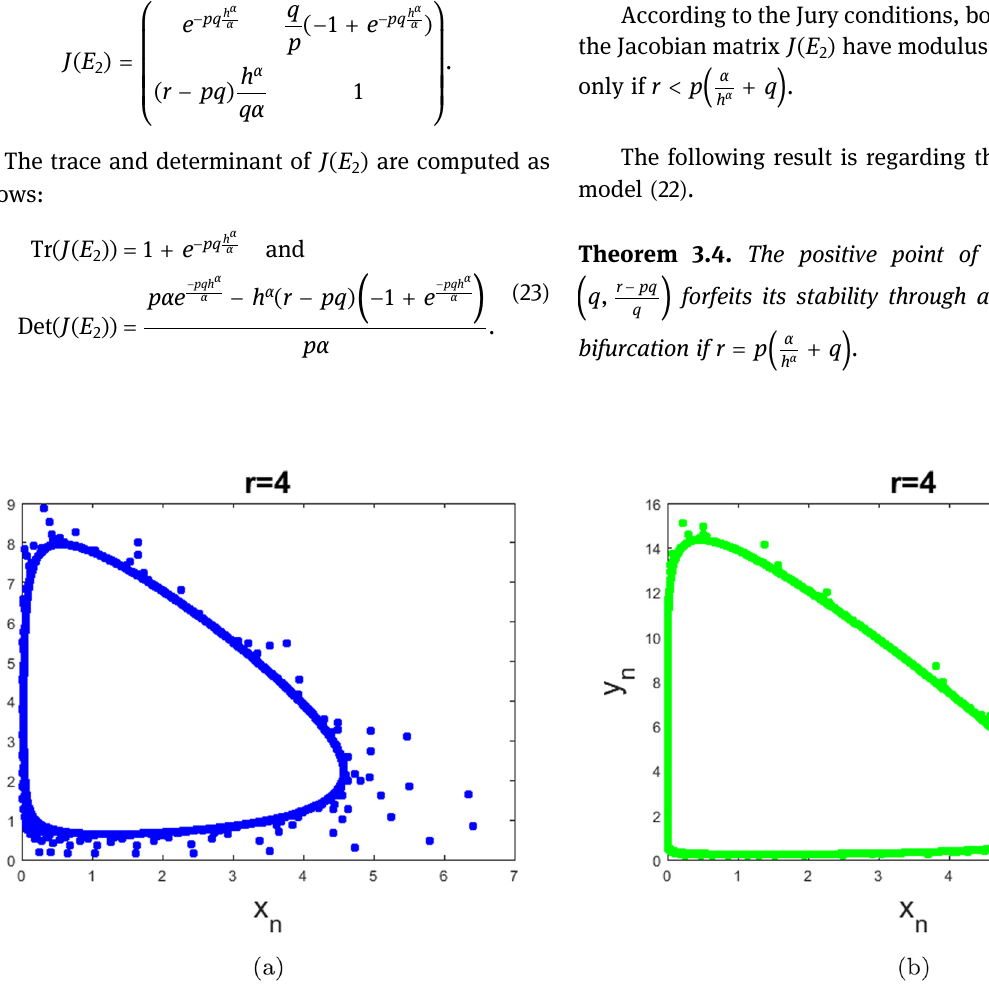
Figure 8: Chaotic attractor for the parameters = p 0.5 , = q 1 , = α 0.95 , = h 0.15 , and = r 4 : ( a ) system ( 8 ) and ( b ) system ( 22 )